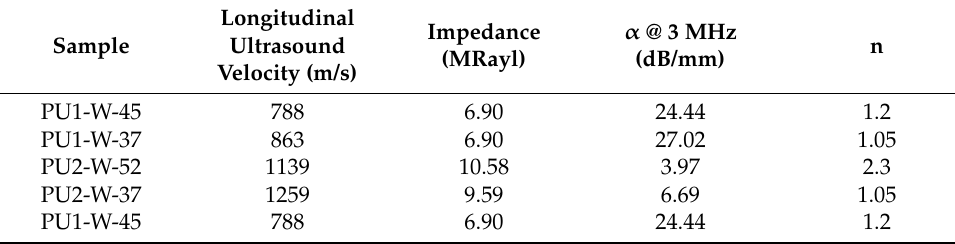
Table 12. Measured ultrasonic properties of the tungsten-loaded polyurethane composites. Longitudinal Sample